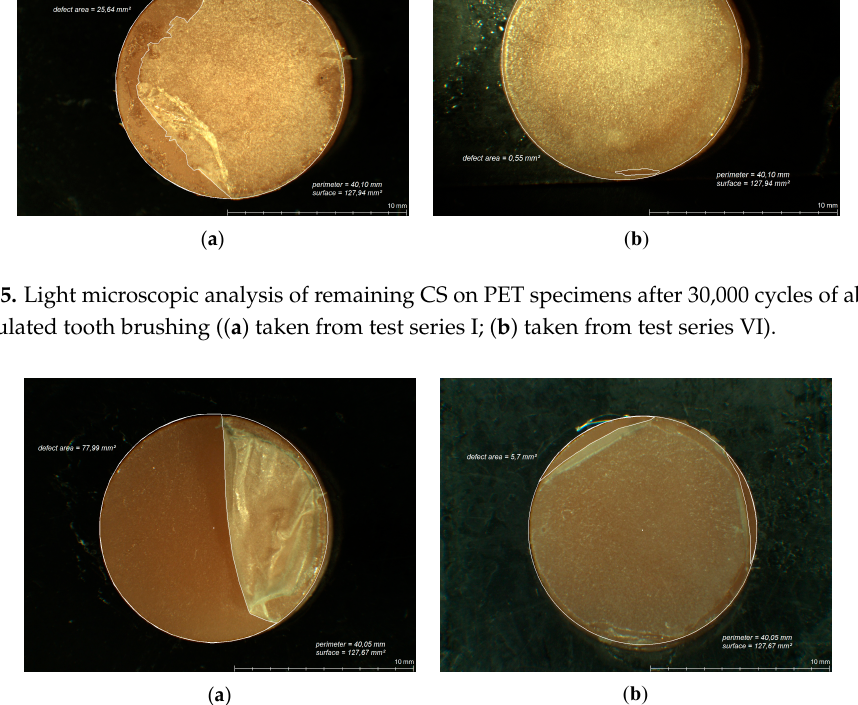
Figure 6. Light microscopic analysis of remaining CS coating on PMMA specimens after 30,000 cycles of abrasion by simulated tooth brushing (( a ) taken from test series I; ( b ) taken from test series VI).